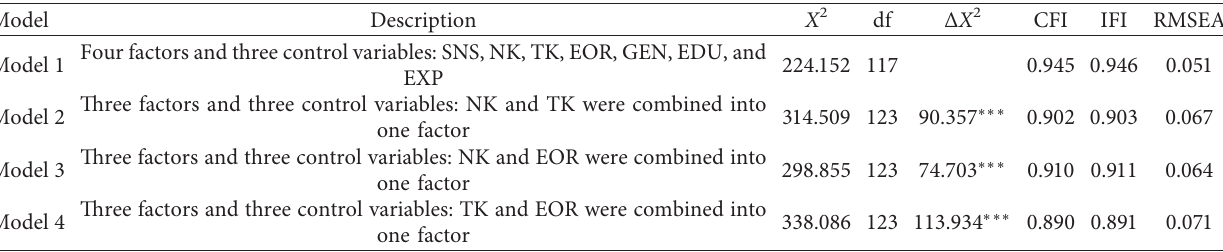
Table 3: Discriminant validity: comparing measurement models.